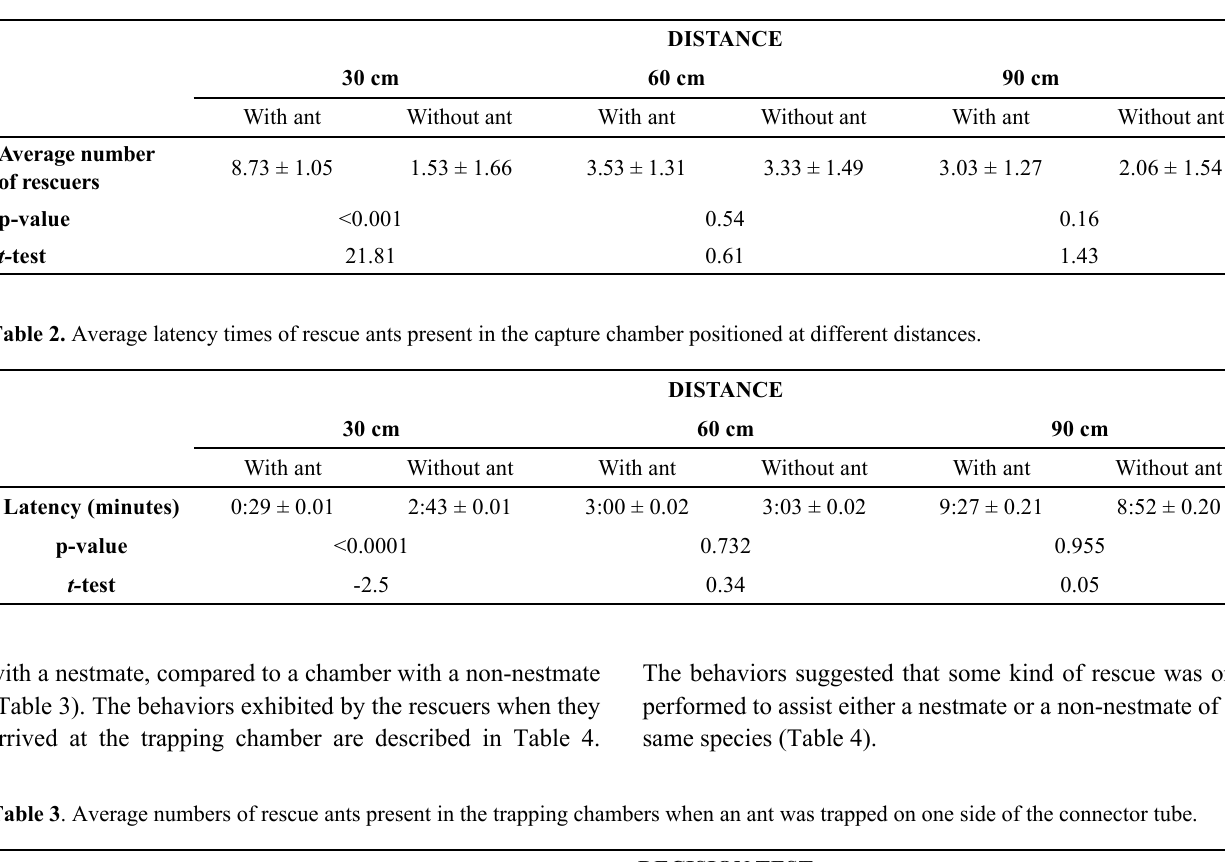
Table 1. Average numbers of rescue ants attending nestmates trapped at different